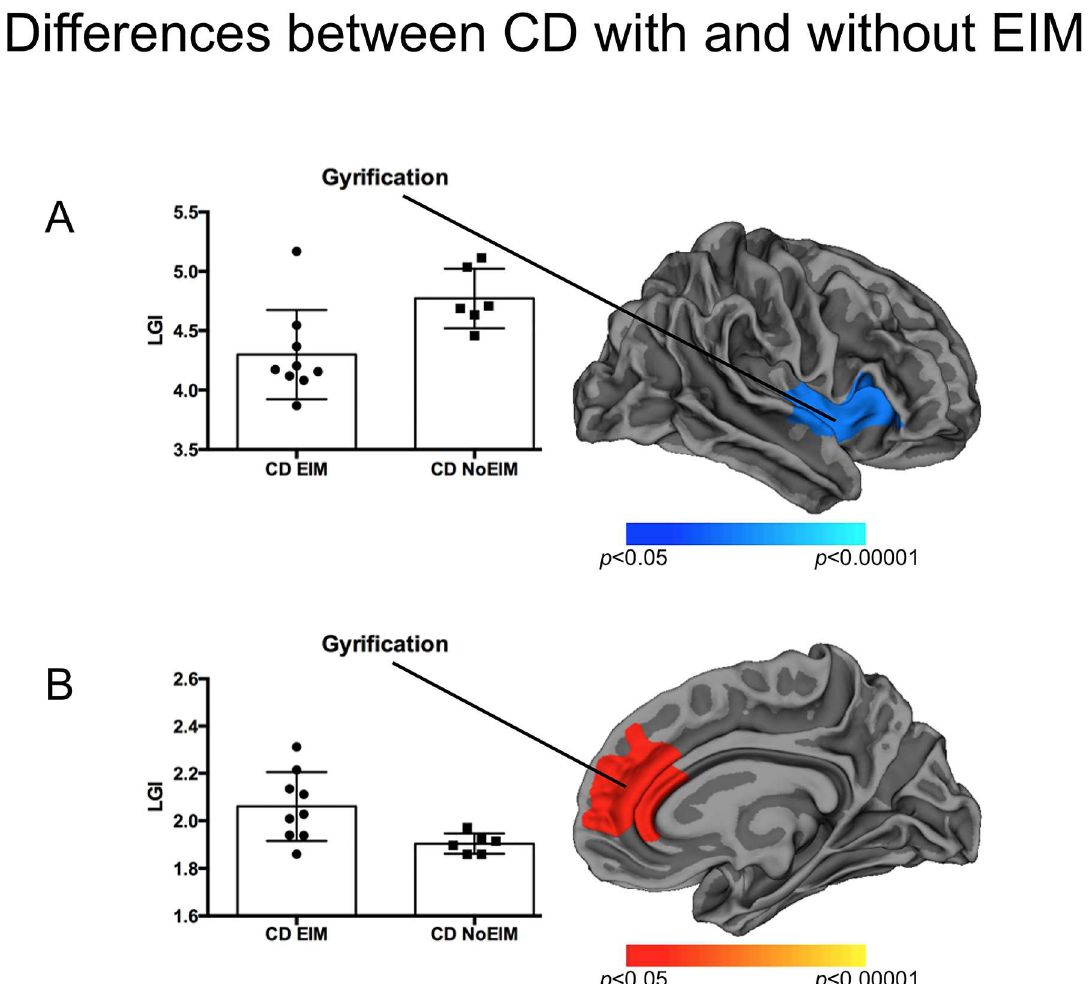
Fig 2. Differences between CD with and without EIM. Cortical statistical maps displayingright-hemispheric lower (A) and higher (B) gyrification in patients with extraintestinal manifestation (p-values corrected for multiple comparisons, vertex-wise analysis over the entire cortical